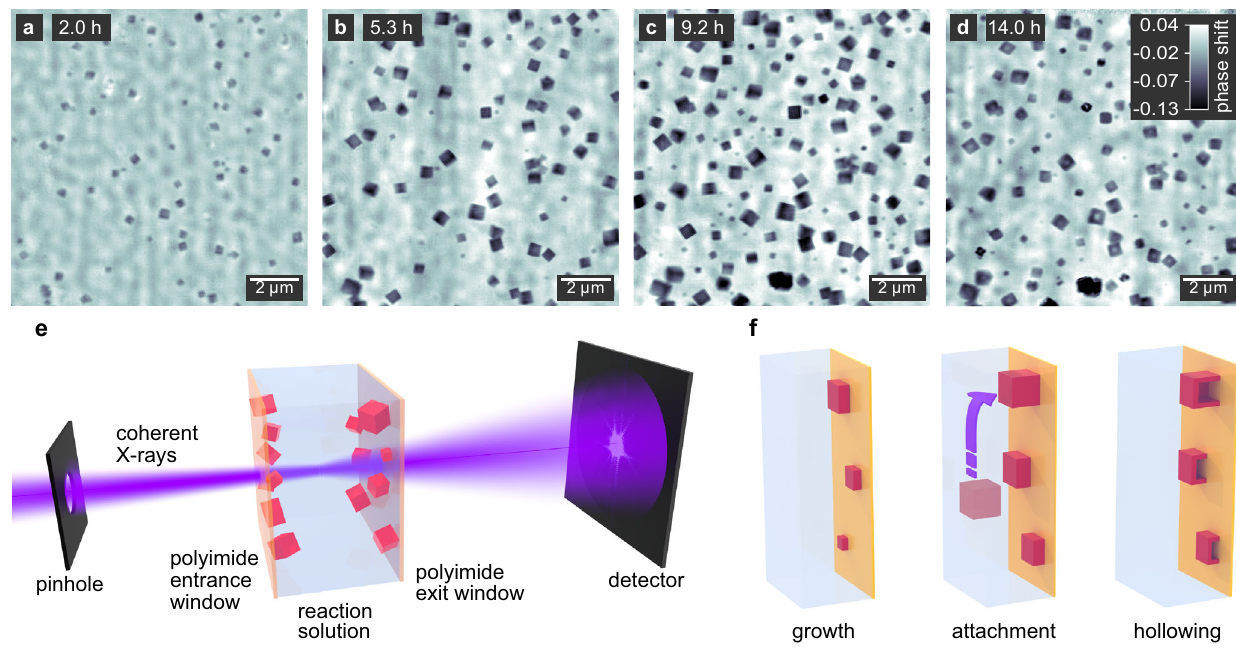
Fig. 1 | Overview of the in situ imaging experiment. a – d Ptychographic recon- structions of nanocubes on the entrance window of the in situ reactor. The gray scaleindicatesthephaseshiftinradian. e Schematicillustrationoftheexperimental